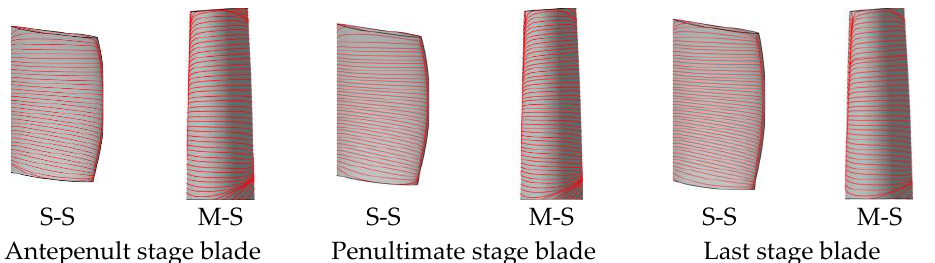
Figure 5. Limiting streamlines of the suction surface on the last three stage blades of the HP cylinder (3.4 MPa back pressure, 60% load ratio).